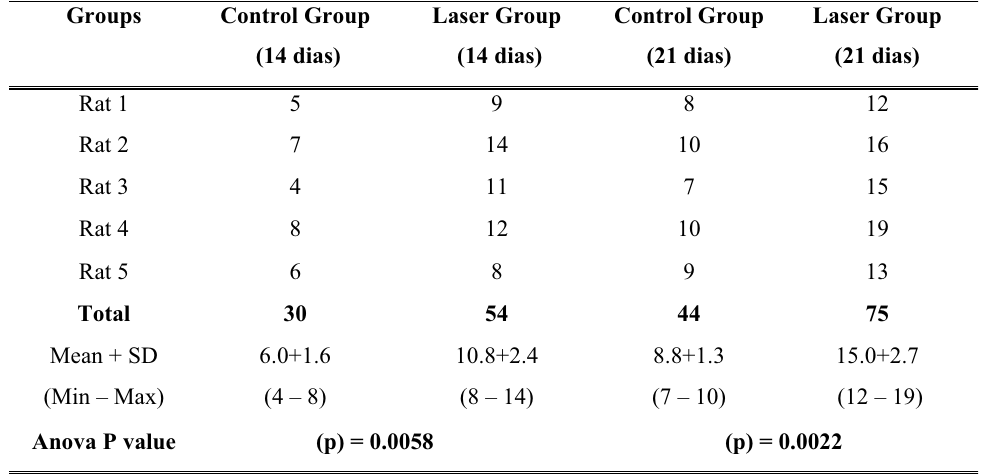
TABLE 3 – Presence of myelinic axons of large diameter in the histological findings at groups in 14 and 21